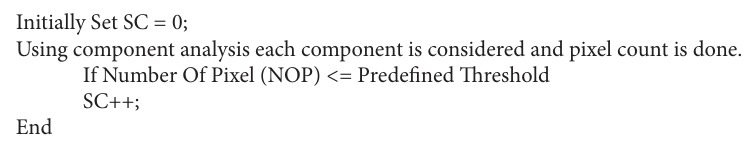
Algorithm 1: Algorithm for computation of small component.